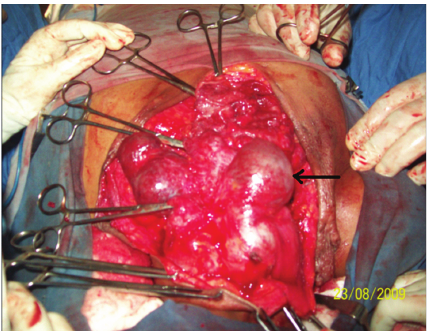
Figure 4: Intraoperative photo showing multiple